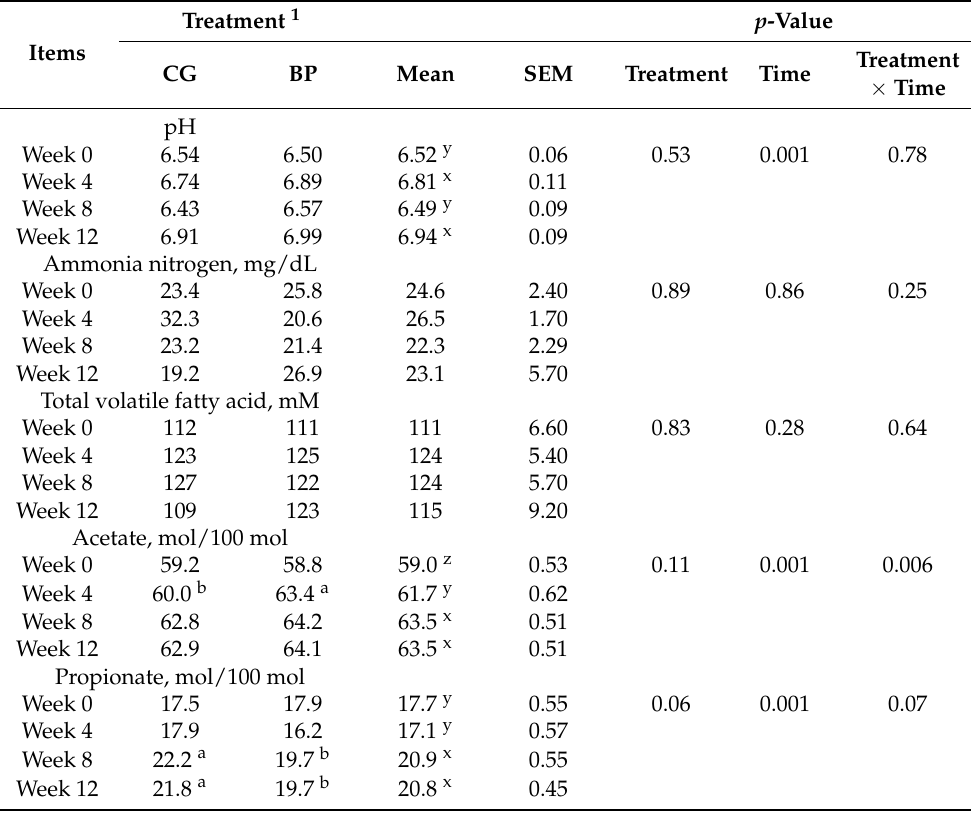
Table 3. Effects of feeding beet pulp in replacement of corn grain on ruminal fermentation character- istics of Korean cattle